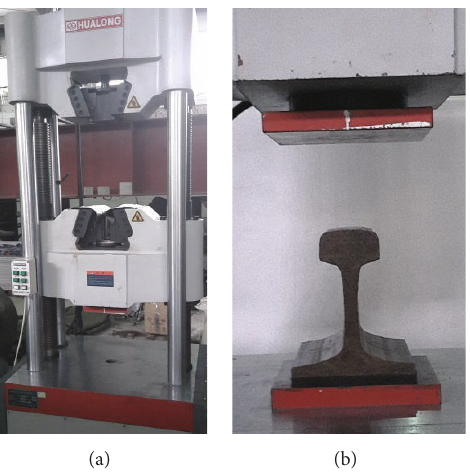
Figure1:LoadtestingofTPErailpads:(a)universaltestingmachine and (b) test setup.